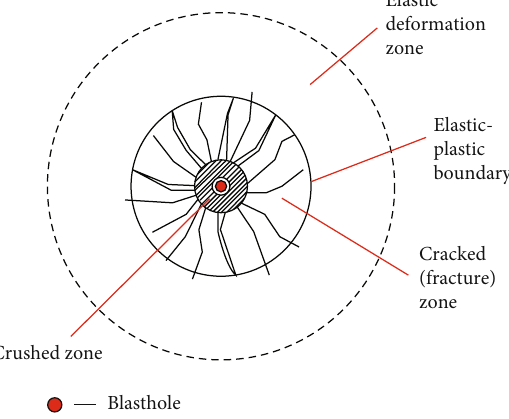
Figure 2: Damage zones surrounding a spherical